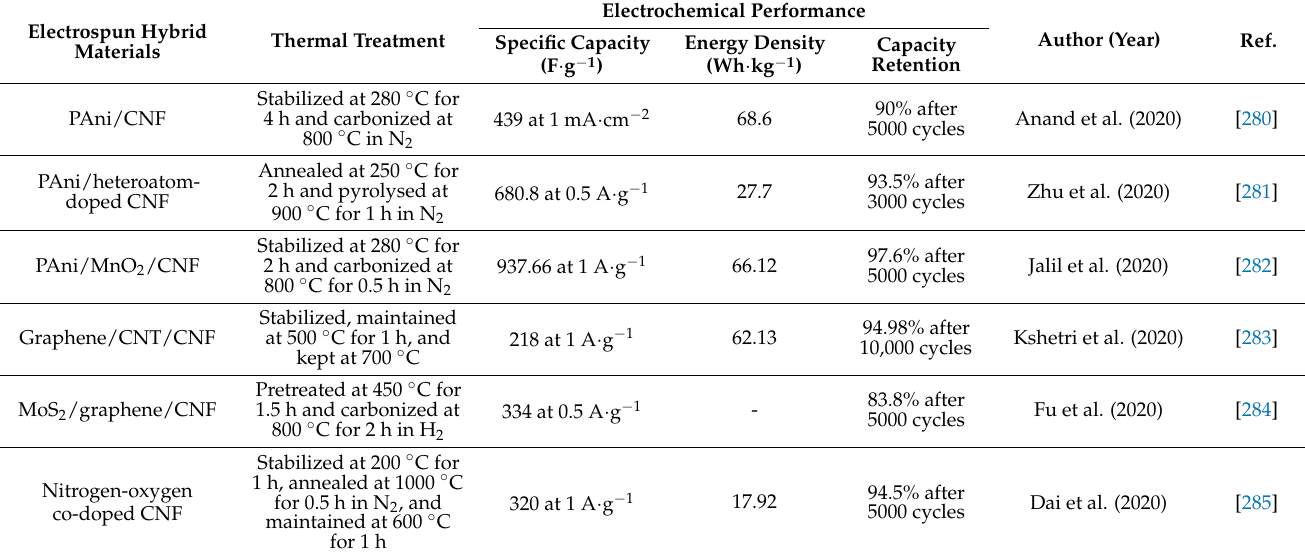
Table 6. Electrospun composites applied as electrode in supercapacitor